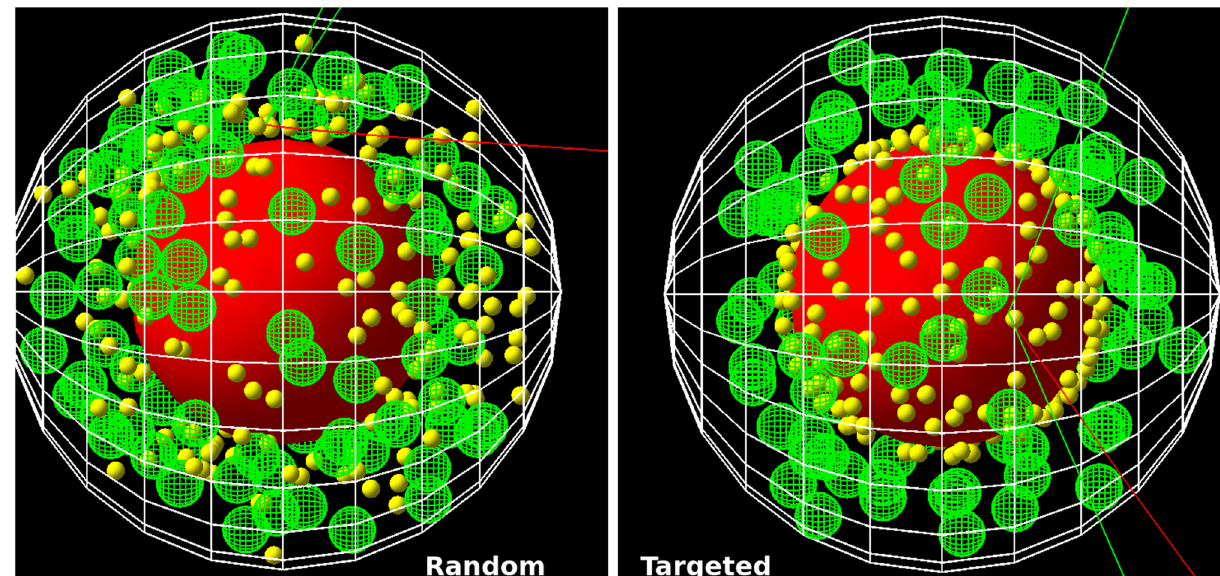
Figure 1. Visualization of the spherical cell model with the nucleus (red) and 90 mitochondria (green) generated by Topas (3.5) 32 and the TsSphericalCellSphericalNP model with the dimensions as given in Table 2. For illustrative purposes two hundred AuNP (yellow) were generated randomly in the cytosol (left) or targeted to the nucleus surface (right) and their radius was set to 200 nm. Electron trajectories are shown in red, photons in